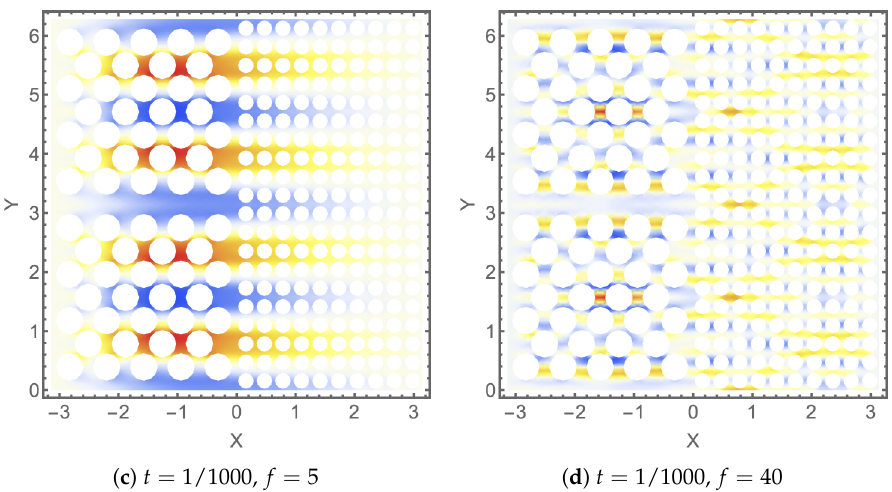
Figure 3. Fourier loading with K = 20. Relative transverse displacement field with temperature colours. Observed energies: ( a ) 0.000167373, ( b ) 0.000849719, ( c ) 0.01163, ( d ) 0.0108526.